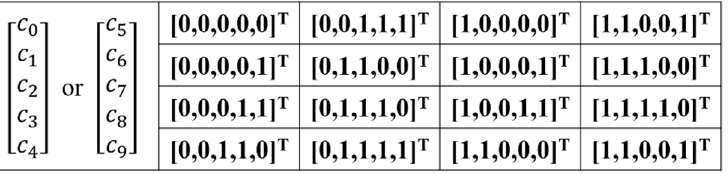
Figure 3. One-to-one mapping and demapping for the proposed modulation code.